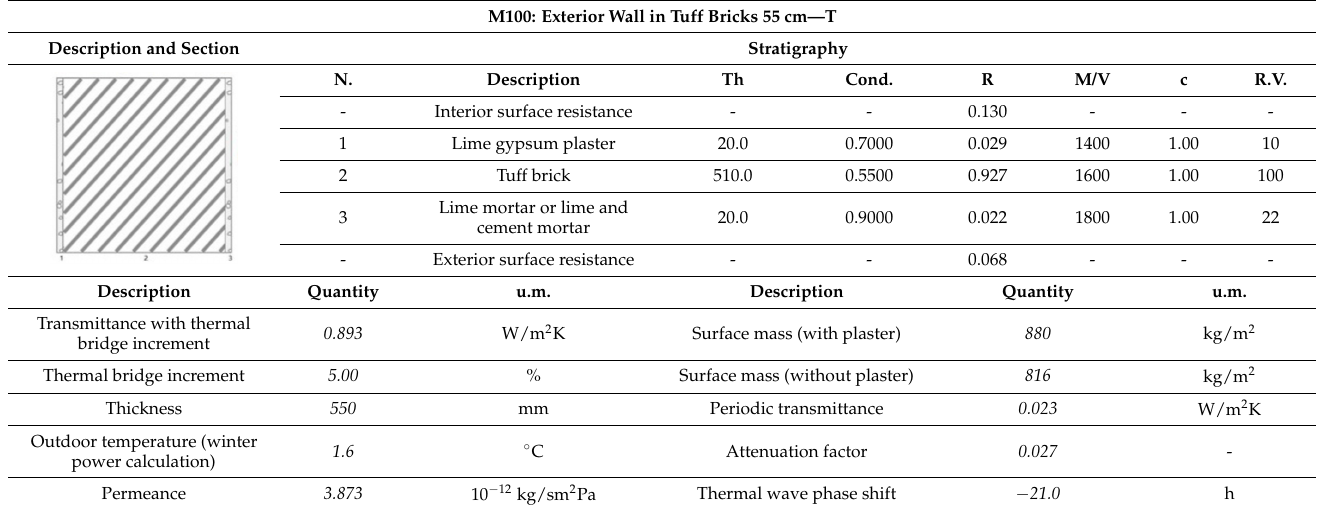
Table 3. M100: exterior wall in tuff bricks 55 cm; ante operam; features.